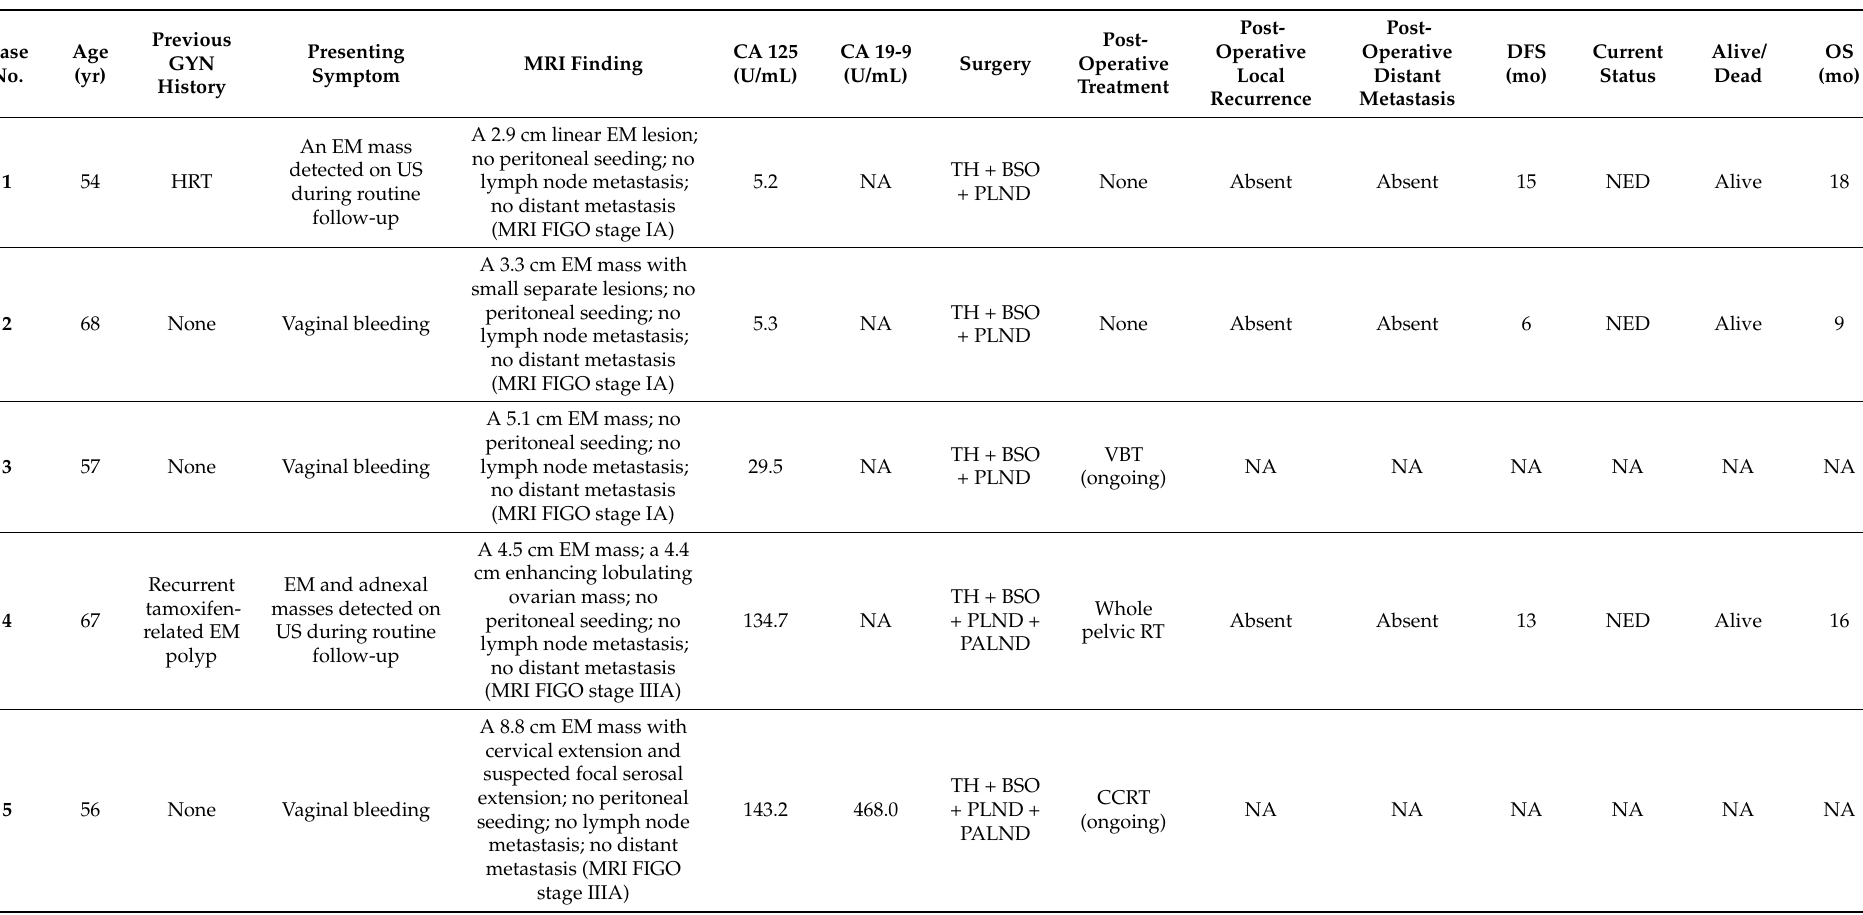
Table 1. Clinical